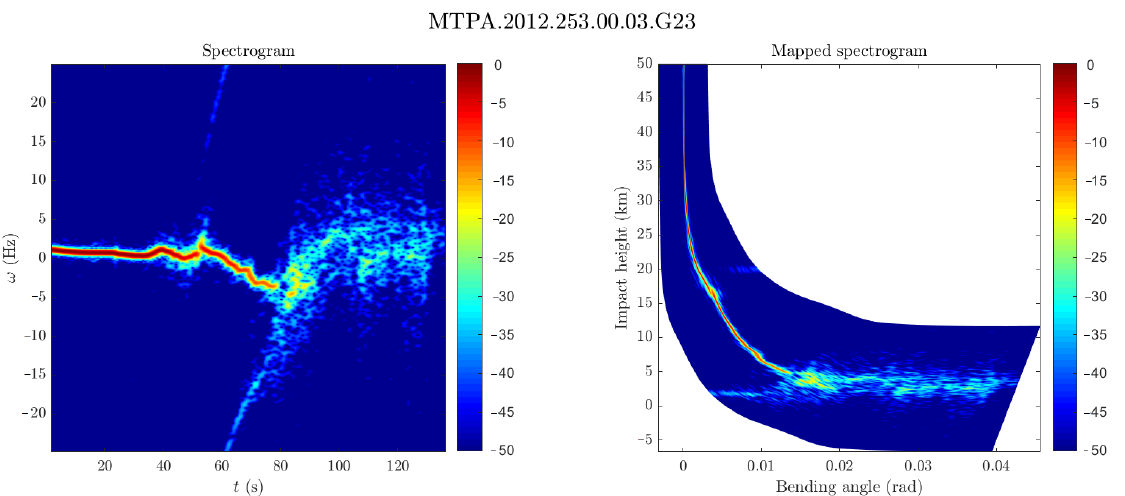
Figure 3. Occultation event from UTC 0003 2012-09-11, 20.16 ◦ S, 114.93 ◦ E. Spectrogram produced by STFT, where values ≤− 50 dB are set to − 50 dB. Left shows the spectrogram in time-frequency coordinates, right shows the spectrogram after mapping to BA and